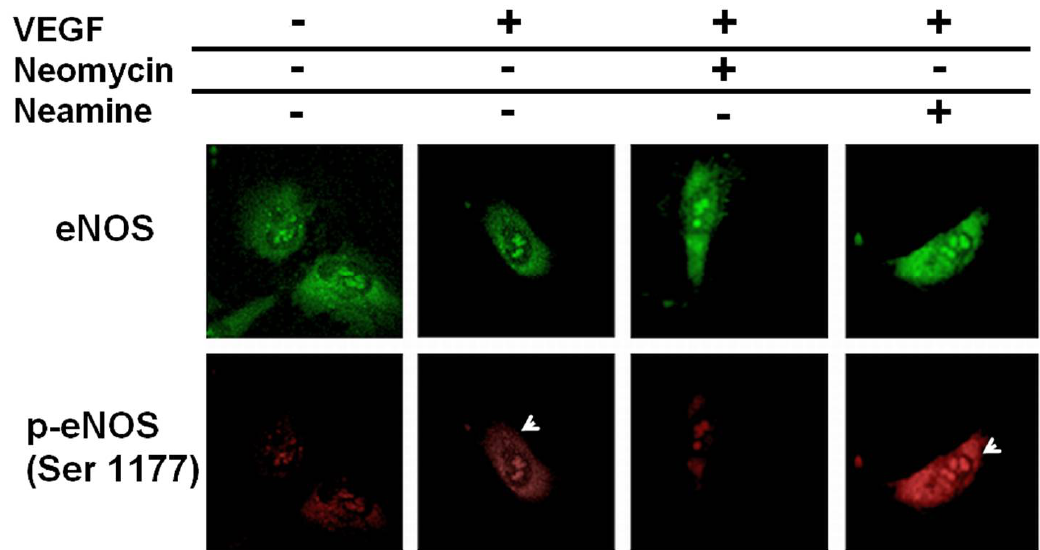
Figure 3. Confocal imaging of eNOS activation. The images obtained for eNOS are shown in green (top row), the ones obtained for its phosphorylated form on the serine 1177 residue, p-eNOS, in red (bottom row). Neomycin and neamine were used as inhibitors. The white arrows indicate the sites where a high level of p-eNOS is observed, in comparison to the control case.